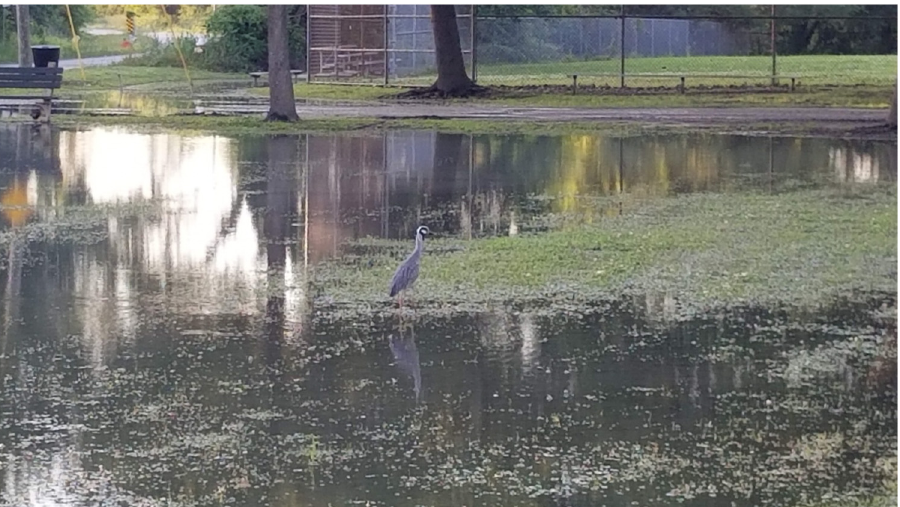
Figure 9. Flooding in Rosemont Park on 24 April 2020, photograph taken by resident and provided to the research team.